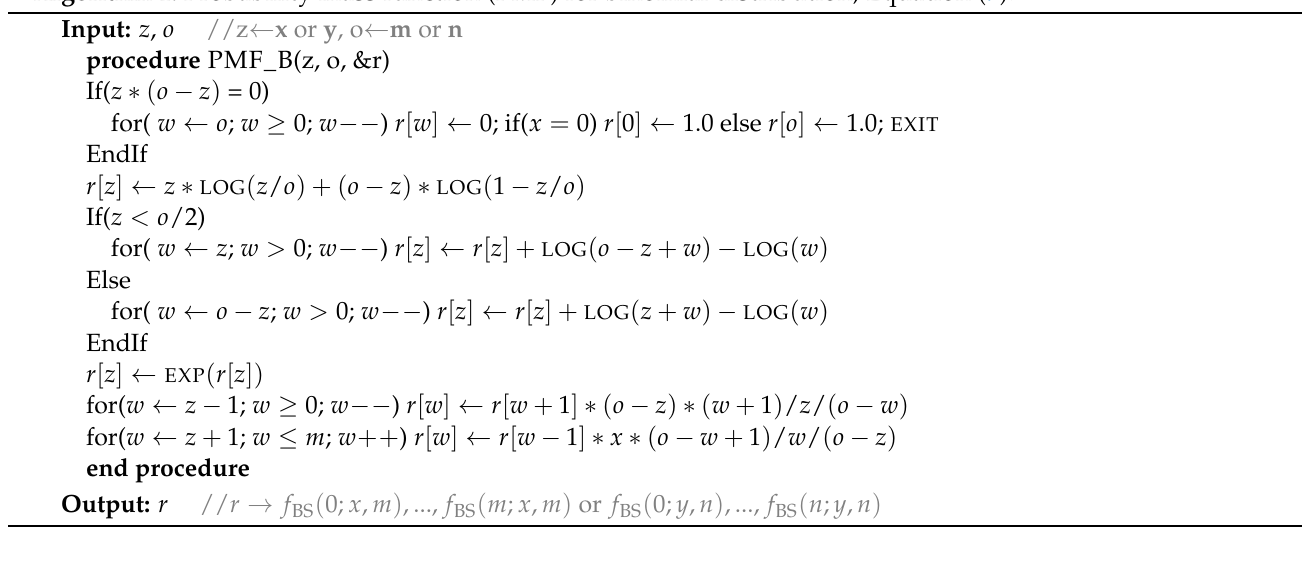
Algorithm 1: Probability mass function (PMF) for binomial distribution, Equation (9).